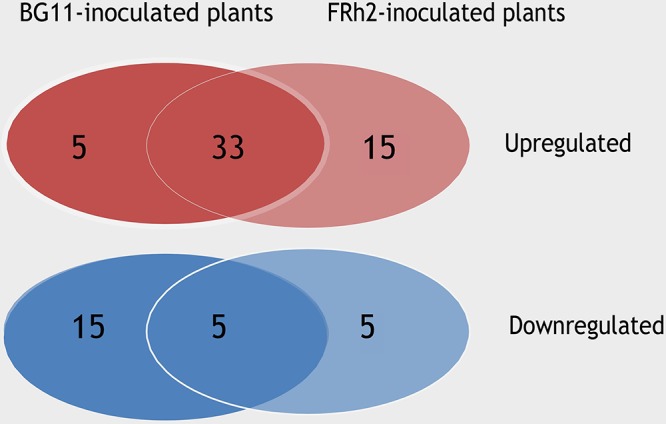
Venn diagram comparing the expression patterns of the shared differentially expressed genes (DEGs) between FRh2- and BG11-inoculated plants.